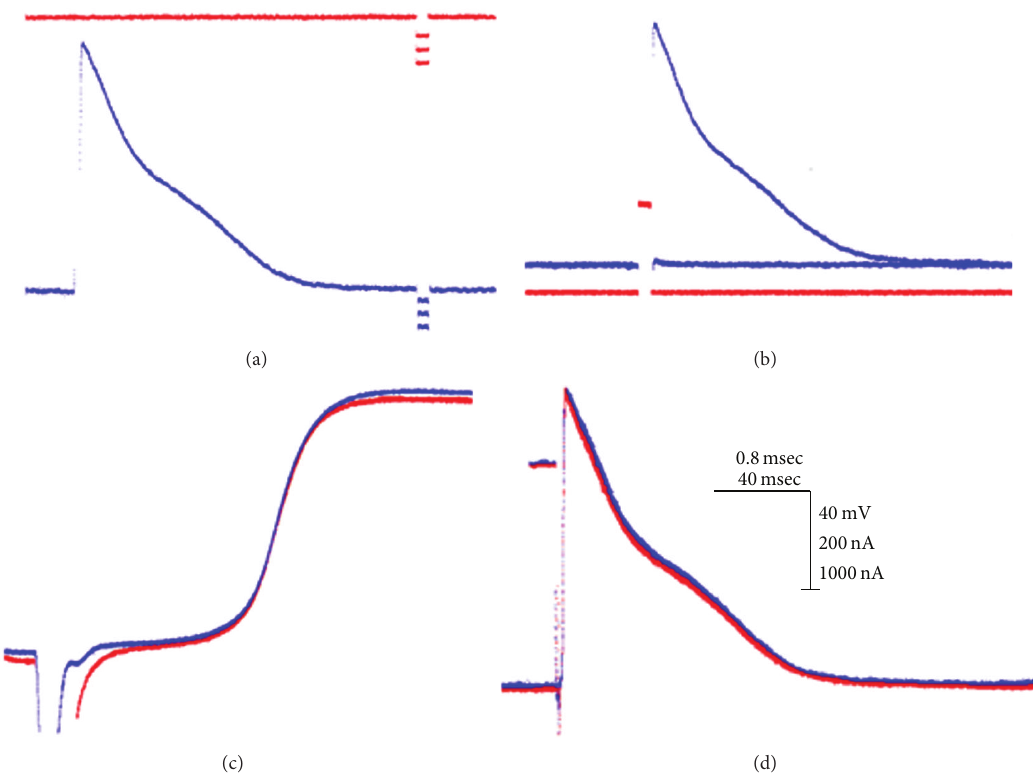
Figure 4: Procedure for determining the input resistance. Steps followed to quantify the input resistance and the intracellular thresholds in the papillary muscles of the hearts of the control rats: (a) injection of the pulse current in late diastole to evaluate the input resistance; (b) determination of the intracellular threshold; (c) simultaneity and shape of the depolarization phase of the action potentials; (d) zero potential of both records obtained from the same